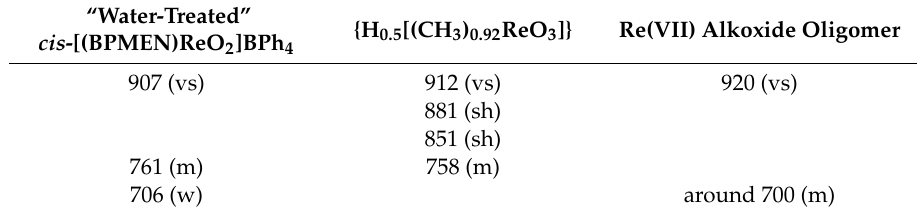
Table 4. Comparison of IR signals in 600–1000 cm − 1 region of “water-treated” cis -[(BPMEN)ReO 2 ]BPh 4